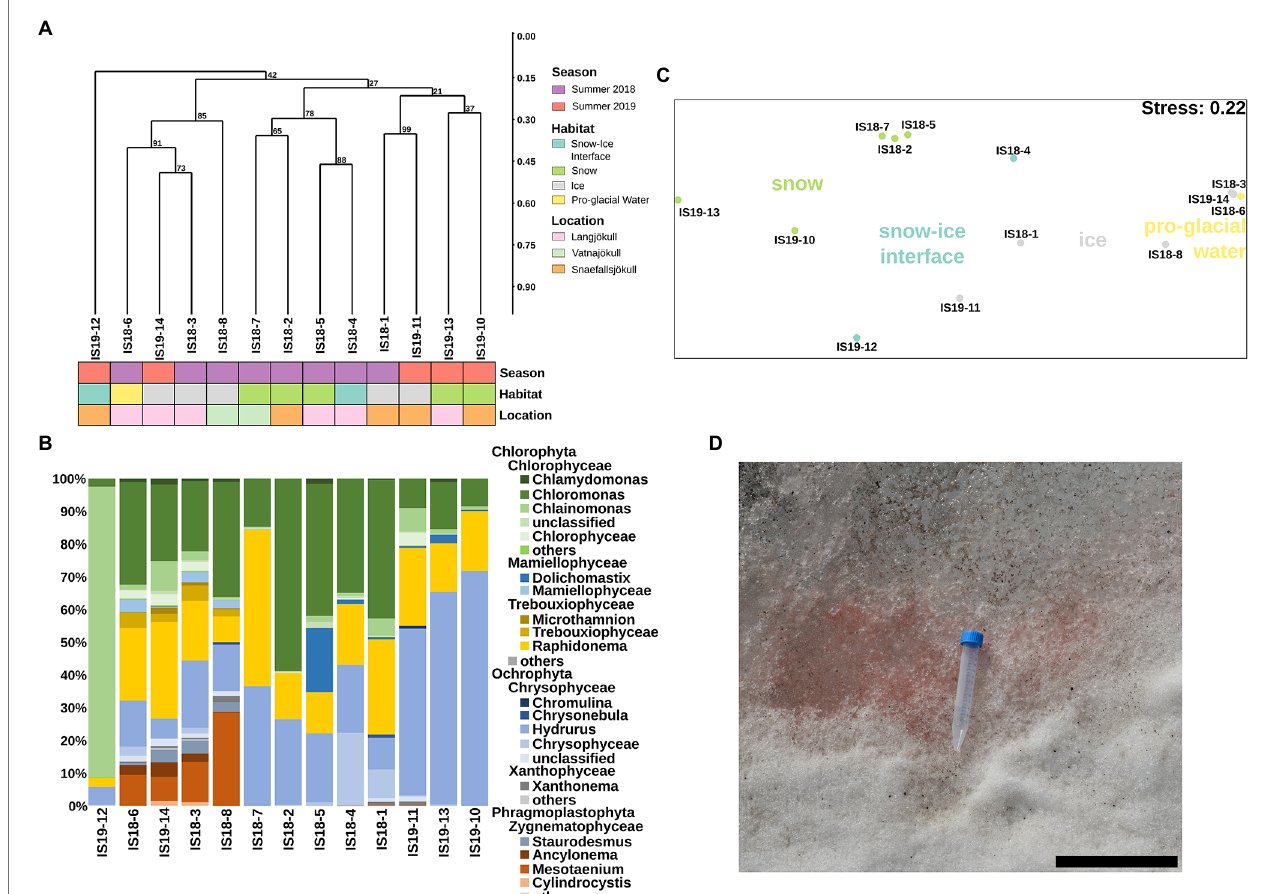
FIGURE 4 | Algae community structure based on 18S rRNA gene abundance. (A) Hierarchical clustering of 18S rRNA algae ASVs using Bray–Curtis and 1,000 iterations underlain by colored boxes that show season (red, purple), location (pink, orange, cyan), and habitat (light blue, green, gray, yellow). (B) Stacked barplots showing 18S rRNA gene ASVs relative abundance at the genus level with bars ordered according to hierarchical clustering. (C) NMDS plot of 18S rRNA gene ASVs using Bray–Curtis dissimilarities of Hellinger transformed ASVs with sampling sites color coded according to habitats as shown in legend in (A) . (D) Close up image of field site IS19-12 showing a dominance of red snow with the 15 ml Falcon tube as size reference and the scale bar representing 12